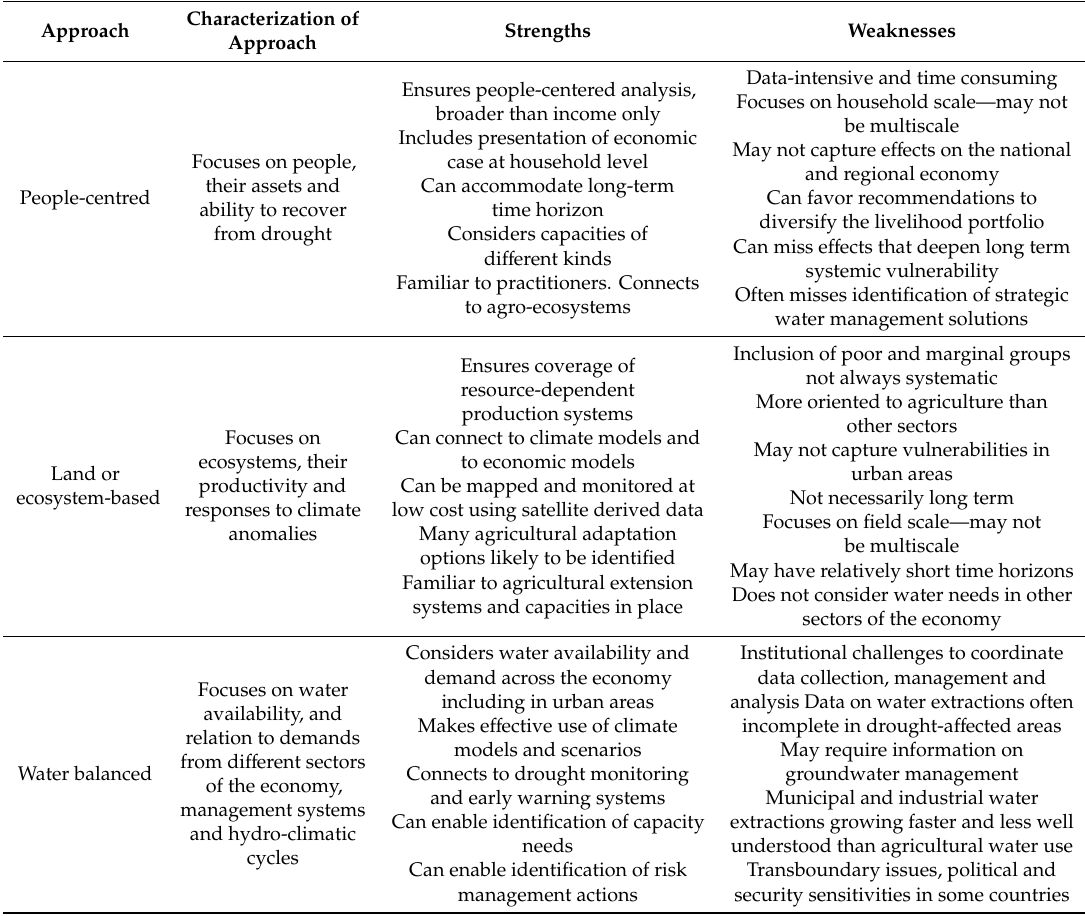
Table 1. Summary of assessment approaches, strengths and weaknesses (source: